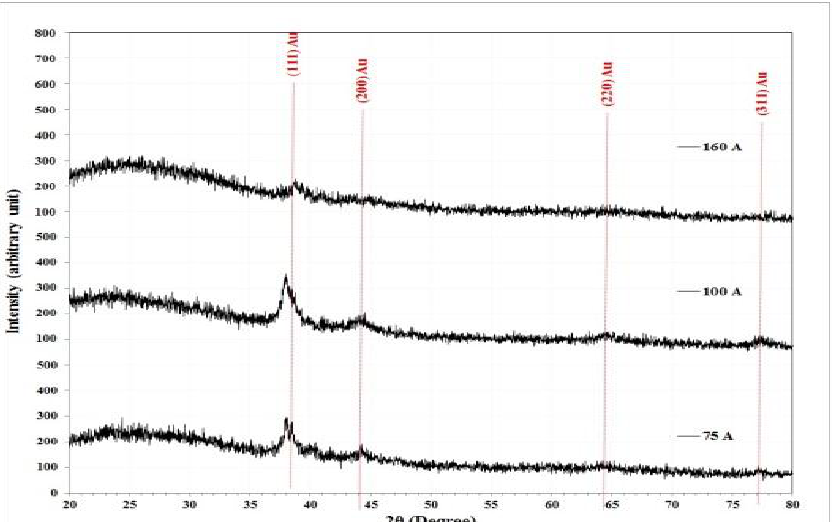
Fig. 3: X-ray diffraction pattern of B-alloy nanoparticles prepared by exploding of wire for a different current (75A, 100A,